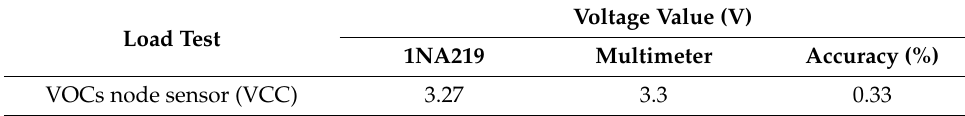
Table 6. Voltage measurements.